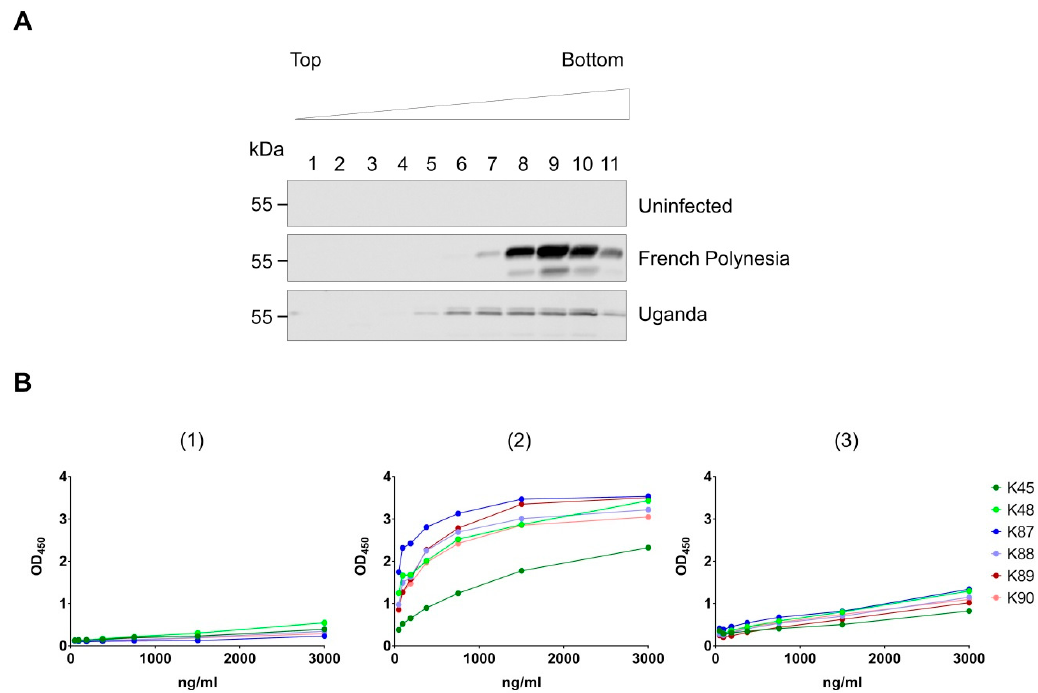
Figure 5. Binding of the purified antibodies to the surface of ZIKV. ( A ) Culture supernatant from uninfected (Ø) or infected Vero cells with the Asian (French Polynesia) or the African (Uganda) strain was collected and ultracentrifuged. The pellet was resuspended and loaded on discontinuous sucrose gradient followed by ultracentrifugation and analysis of the collected sucrose fractions by Western blot. The purified antibody K87 (specific for ED1 + 2) was used as primary antibody, and anti-rabbit was applied as secondary antibody; ( B ) The sucrose fraction number 10 from uninfected cells (1), from the Asian strain-infected cells (2), or from the African strain-infected cells (3) were used for